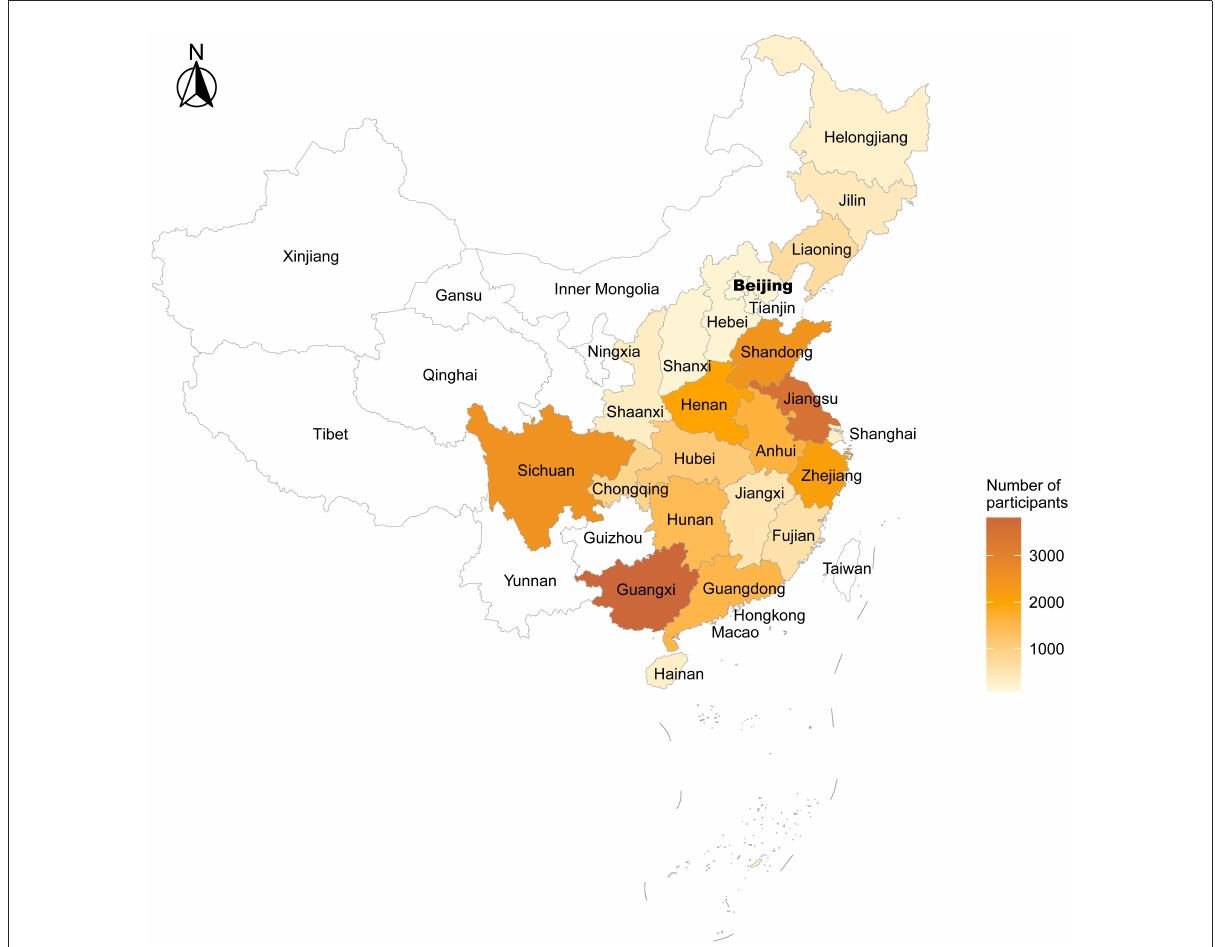
FIGURE2 Spatial distributions of the study population. In the present study, province with the most study participants was Guangxi ( n = 3,808), followed by Jiangsu, Sichuan, Shandong, Zhejiang, Henan, Anhui, Guangdong, Hunan, Hubei, Chongqing, Liaoning, Fujian, Jiangxi, Jilin, Shaanxi, Shanghai, Hainan, Helongjiang, Hebei, Shanxi, Tianjin, and